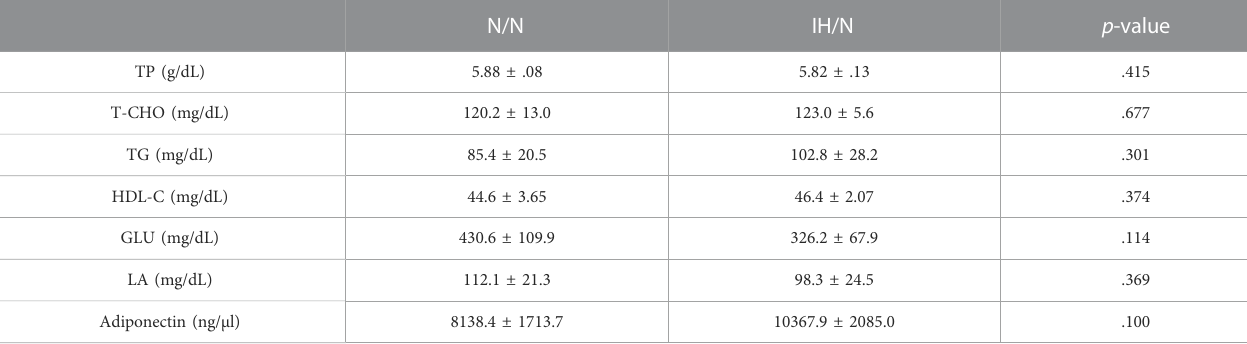
TABLE 1 Serum biochemistry data of N/N and IH/N rats.